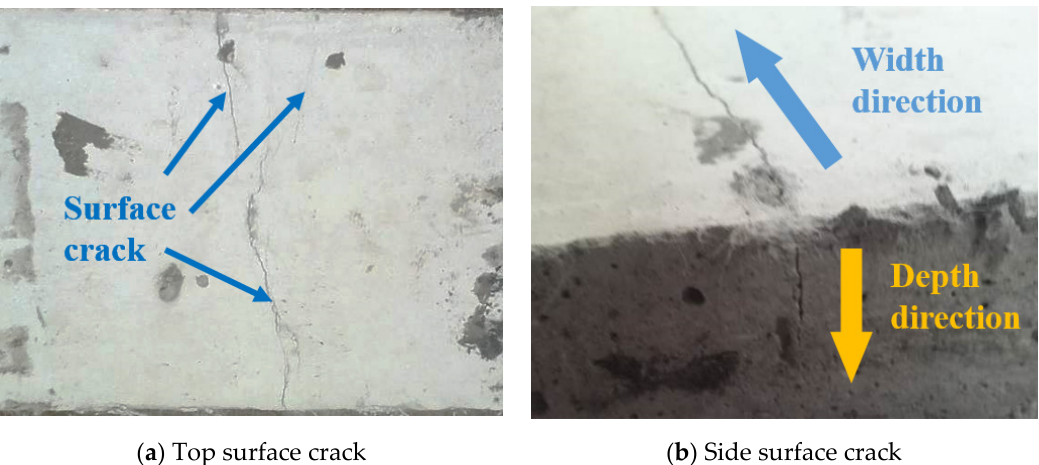
Figure 13. ECC fatigue cracks in composite beams under the improved three-point bending fatigue test (ITBF) test.